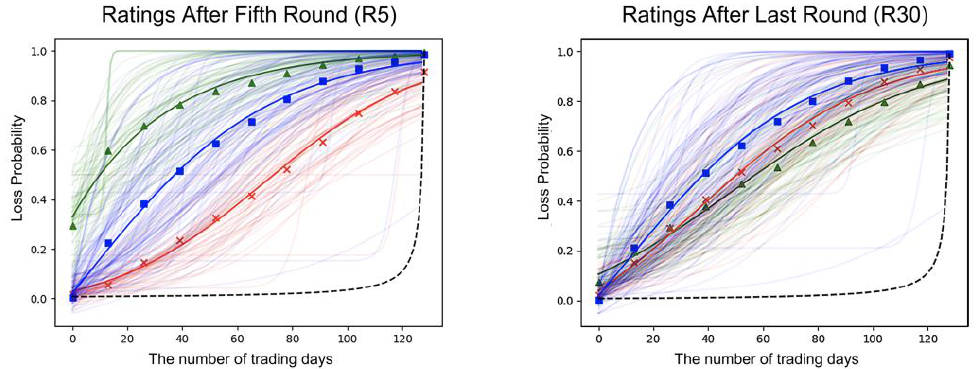
Figure 1. Fitted risk probability rating curves after the fifth round (R5) and fitted risk probability rating curves after the last round (R30). Note: The two panels showed the fitted risk probability rating functions for each participant’s probability ratings (light colored) based on the mean values for 11 estimates of the risk of continuing to hold stocks in the next trading day. R5 represents the fitted risk probability curves after participants completed the first five rounds of the SIT, and R30 after participants completed all rounds of the SIT. The three different colors of fitted risk probability rating functions in R5 and R30 represent three different initial investment experiences: The green curve (triangles) represents the HIE; the blue curve (square) represents the CIE; the red curve (exes) represents the LIE. The black dashed curve is the objective probability of the loss set by the experimenter based on Equation (1).